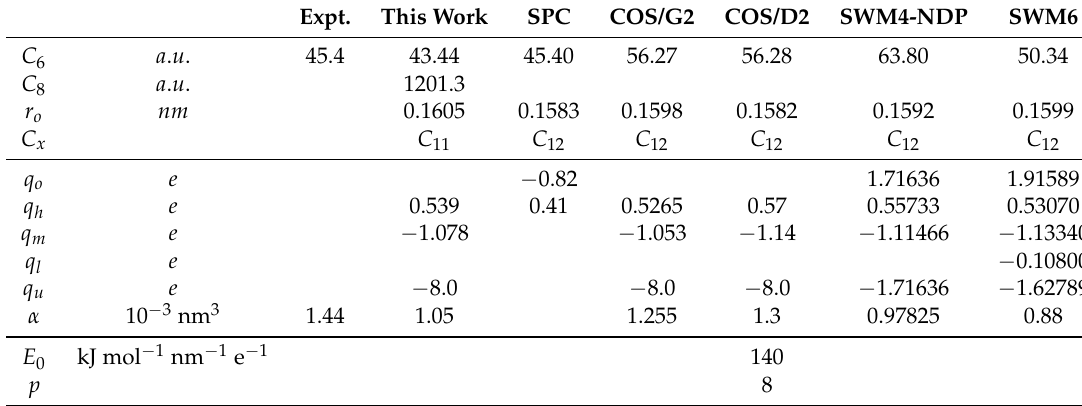
Table 1. Force-field parameters for dispersion and electrostatic interactions. Values obtained in this work are listed together with values used in SPC and in other charge-on-spring (COS) and Drude-oscillator (DO) water models. As the form of the van der Waals potential energy function used here is different from the other models (by means of inclusion of a C 8 and C 11 term in this work), the functional form of the repulsive term is listed as C x . Van der Waals parameters are listed using homo-dimer dispersion parameters and repulsion is listed in terms of a van der Waals radius r o . Electrostatic parameters are listed for the atomic site of the oxygen ( q o ), the atomic site of the hydrogen ( q h ), the offsite position ( q m ), oxygen lone pairs ( q l ) and the charge on the COS particle ( q u ). Damping power ( p ) and the damping field strength ( E 0 ) are only used in the COS/D2 model. All water models (except SPC) include a single polarizable site; therefore, a molecular polarizability ( α ) is listed. Note that for charge assignments the values listed are the charges as written in the topology; GROMOS-style force fields (This work, SPC, COS) assign internally an effective charge of q i - q COS for a polarizable site, to balance out the introduction of a large COS charge. Reference values for C 6 and α were taken from Refs. [64,68], respectively. Values for SWM4-NDP and SWM6 DO water models were taken